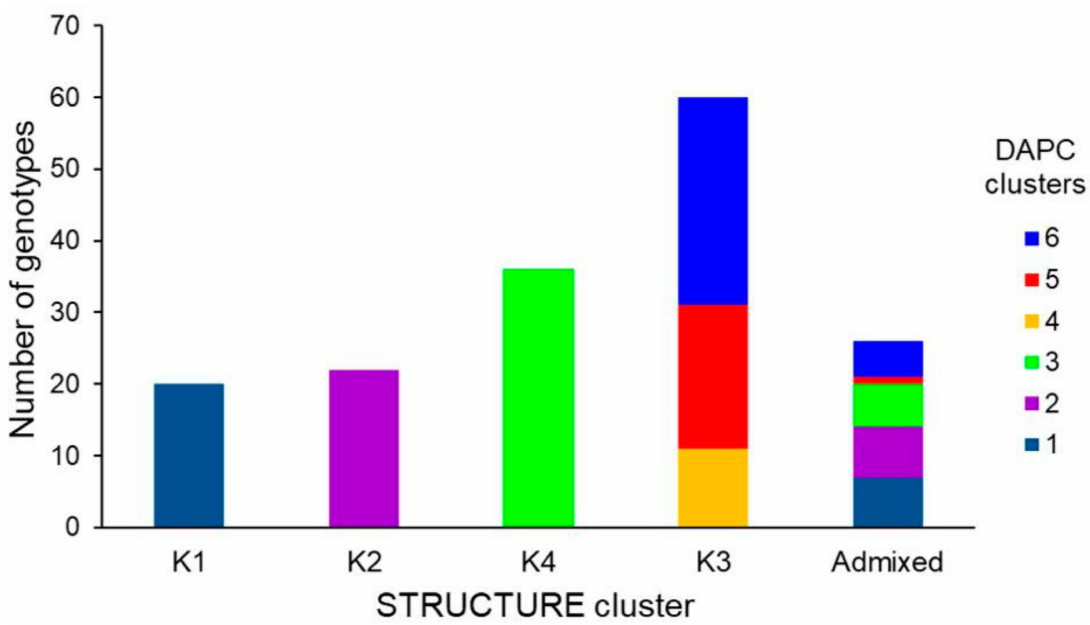
Figure 3. Comparison of individual assignment between DAPC and STRUCTURE analyses for 136 ex situ accessions and 28 durum wheat varieties based on 44 SSRs. Individuals are considered assigned to a cluster if their posterior probability in that cluster is at least 0.7.